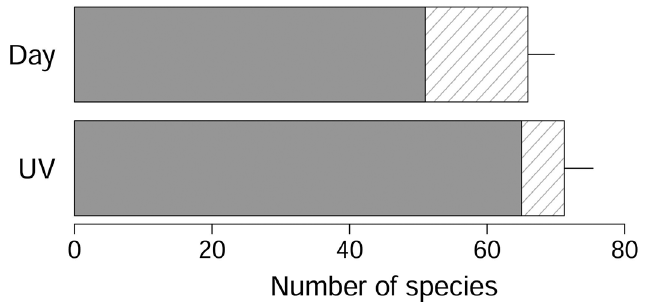
Fig. 6. Specific richness of Mantodea collected with two main sam- pling methods; day capture (Day) and trapping with UV light at night (UV); grey chart = observed richness; dashed chart = esti- mated richness (ACE index) and associated standard deviation.